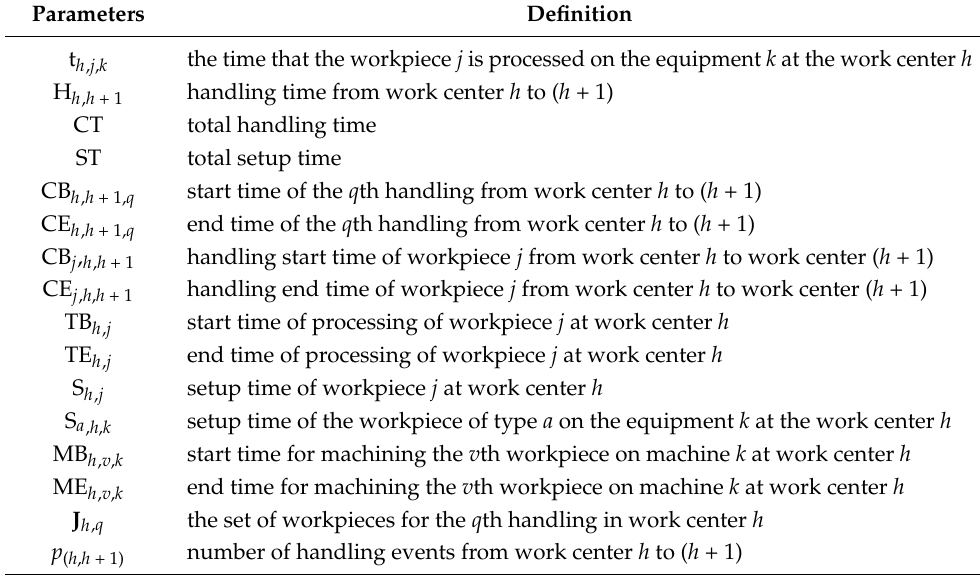
Table 2. Definition of